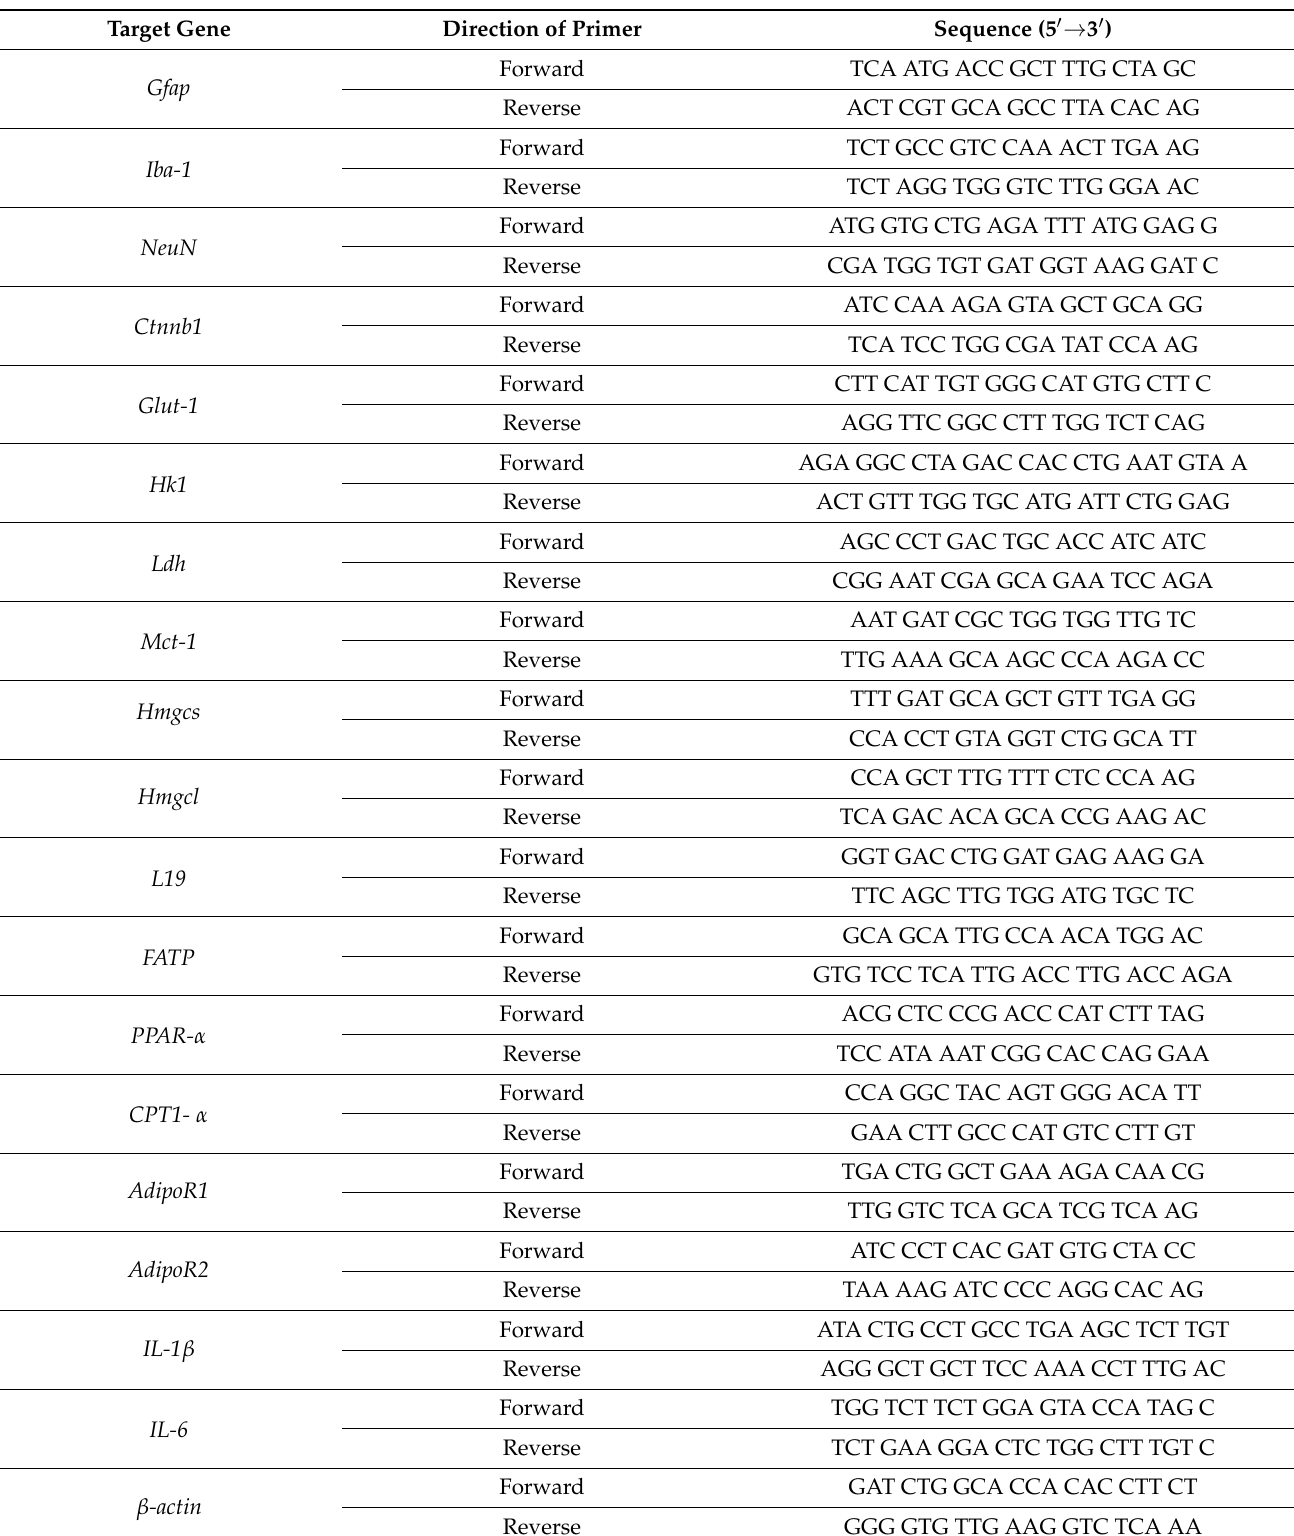
Table 1. Real-time PCR primer